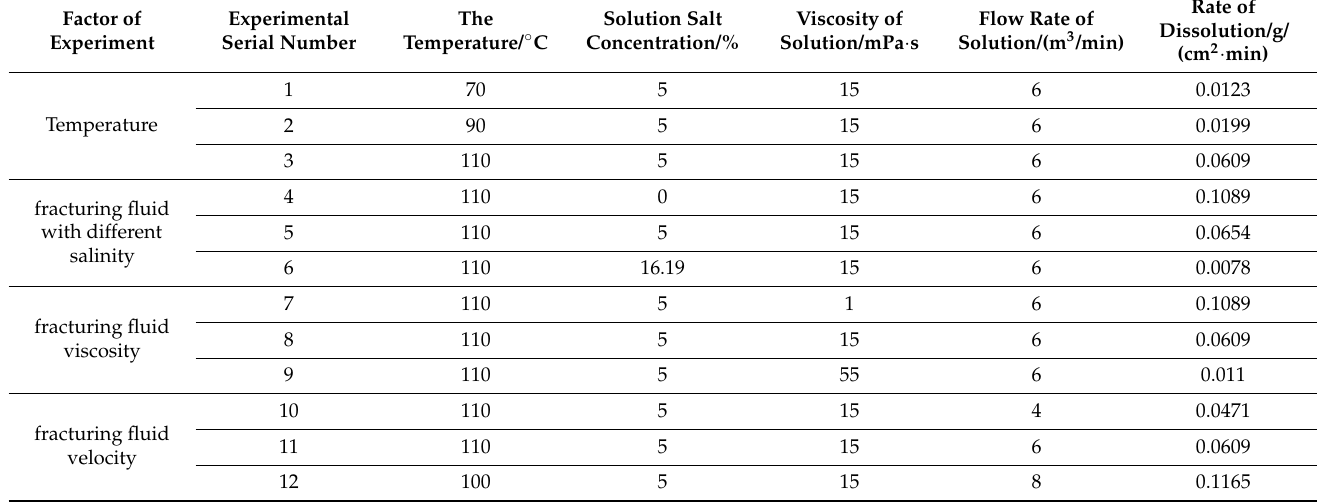
Table 3. Summary of the influences of various factors on dissolution rate.